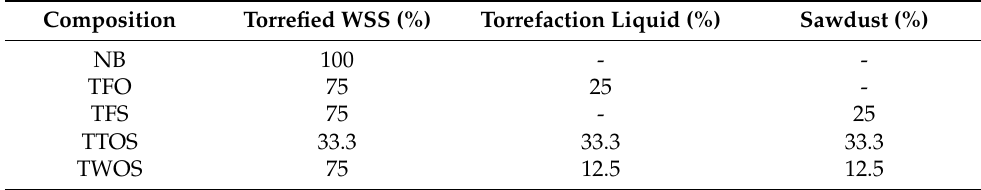
Table 2. Formulations for pelletizing with the torrefaction liquid and